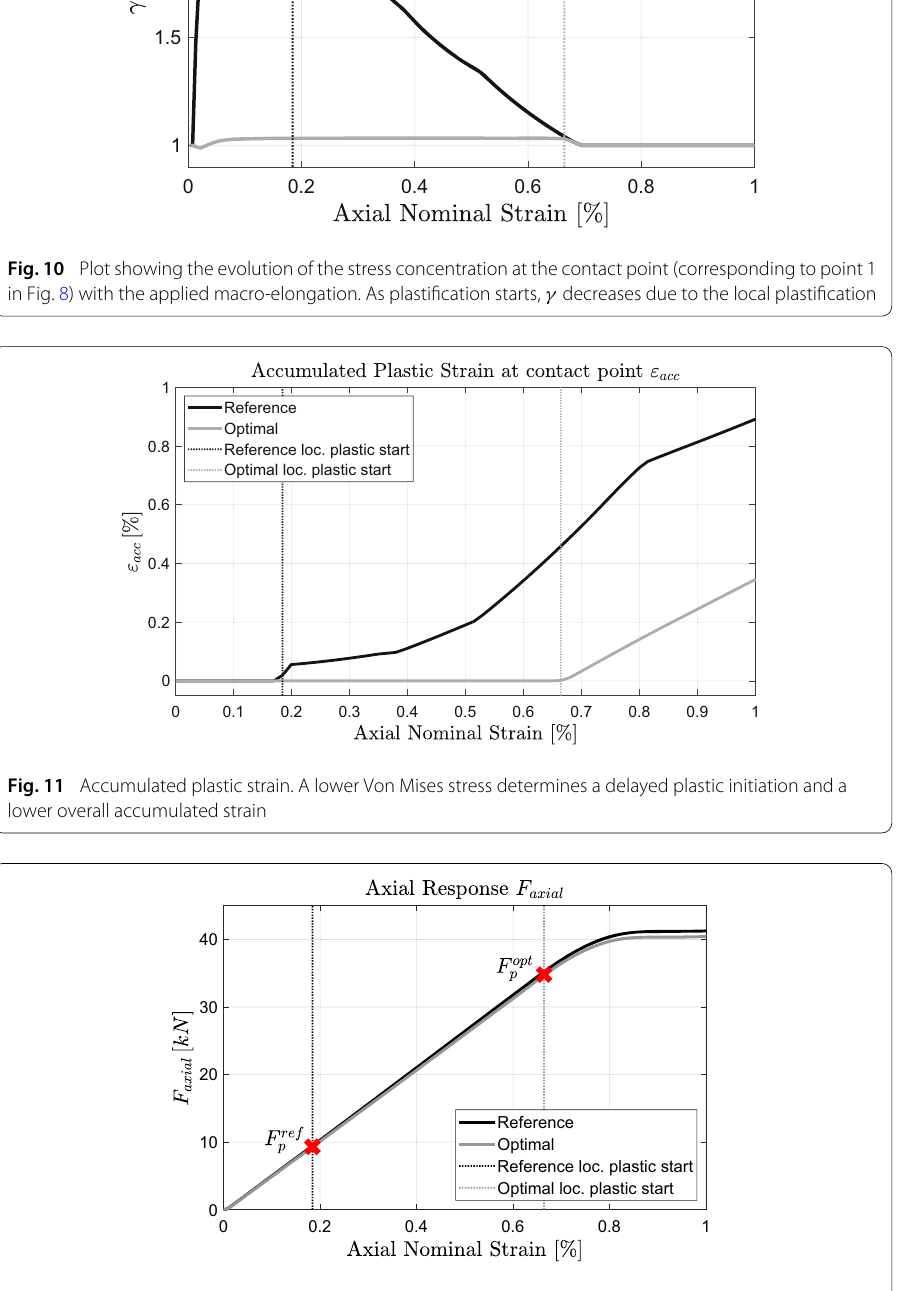
Fig. 12 Global axial response of the reference and the optimal strand. The optimal shape delivers a 2 . 5% lower limit